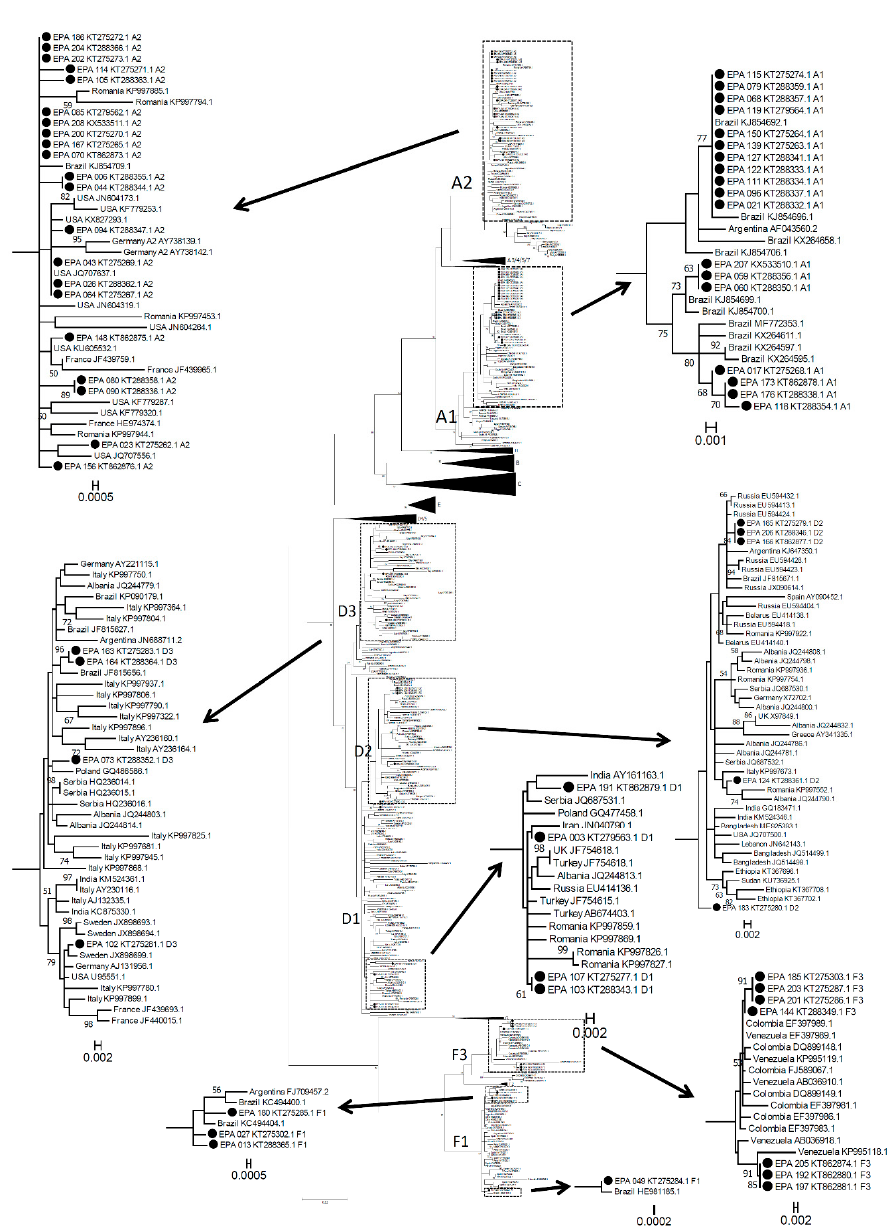
Figure 1. Maximum Likelihood phylogenetic tree of the Reverse Transcriptase (RT) region of HBV including 66 HBV isolates from Italian acute hepatitis B infection (AHB) patients (from this study marked by a dot and indicated as EPA + consecutive identification number + accession number, with the indication of genotype/subgenotype) and 487 isolates from infections worldwide (with geographical origin and accession number). Bootstrap values >50 are displayed. Subtrees representing B, C, G and H genotypes, A3-A7, D4/D5 and F2 subgenotypes (not relevant to the aims of this study) have been collapsed for the sake of space. The boxes in the main tree include subtrees containing the sequences from this study (marked by a black dot). These subtrees have been expanded for a better reading of the sequence